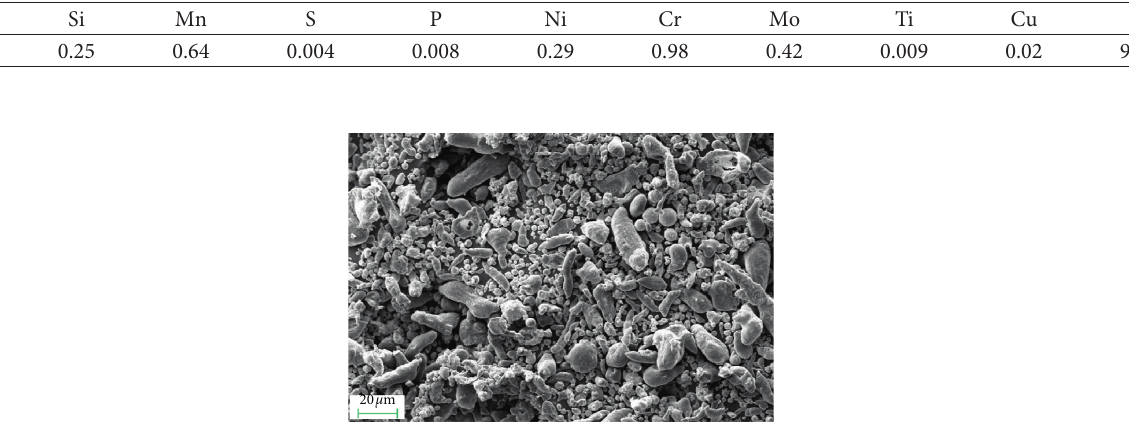
Figure 1: SEM image of mixed powder of Al and Zn (40% Al-60% Zn).